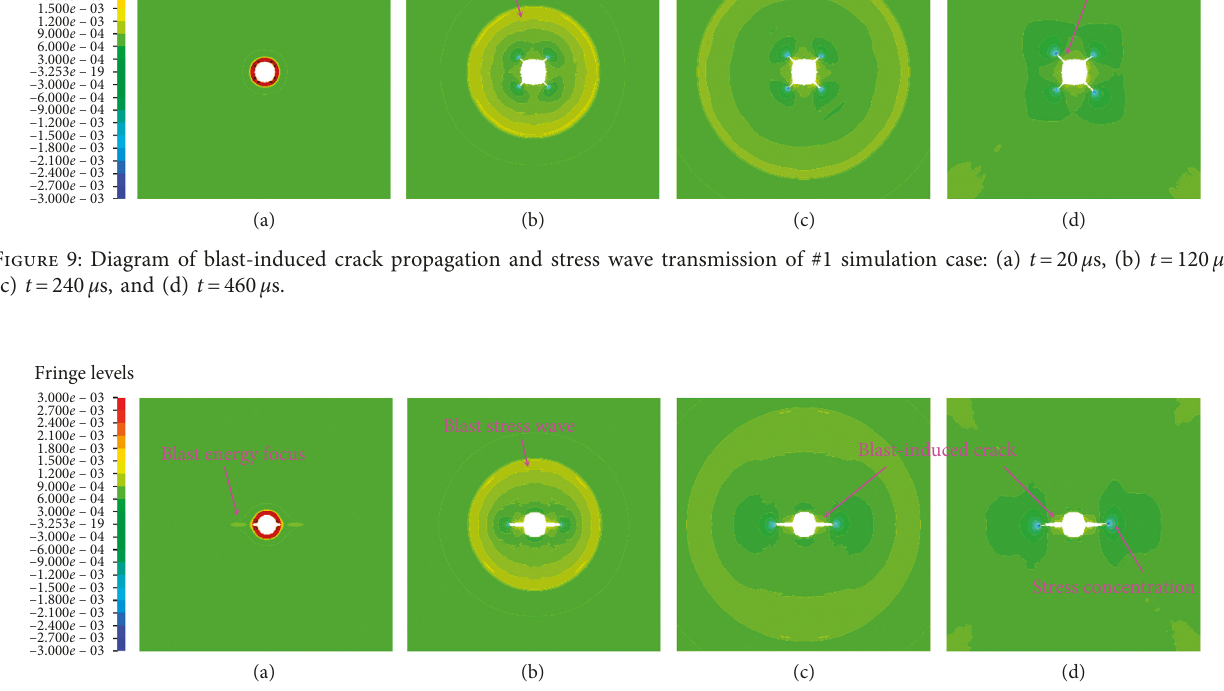
Figure 10: Diagram of blast-induced crack propagation and stress wave transmission of #2 simulation case: (a) t � 20 μ s, (b) t � 120 μ s, (c) t � 240 μ s, and (d) t � 460 μ s.